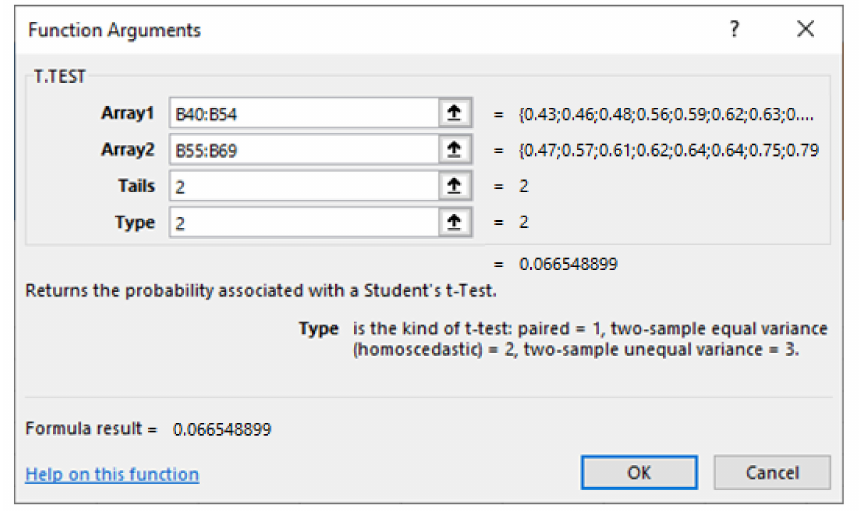
Figure 7. Independent sample t -test with T.TEST function in MS Excel. Source: Microsoft